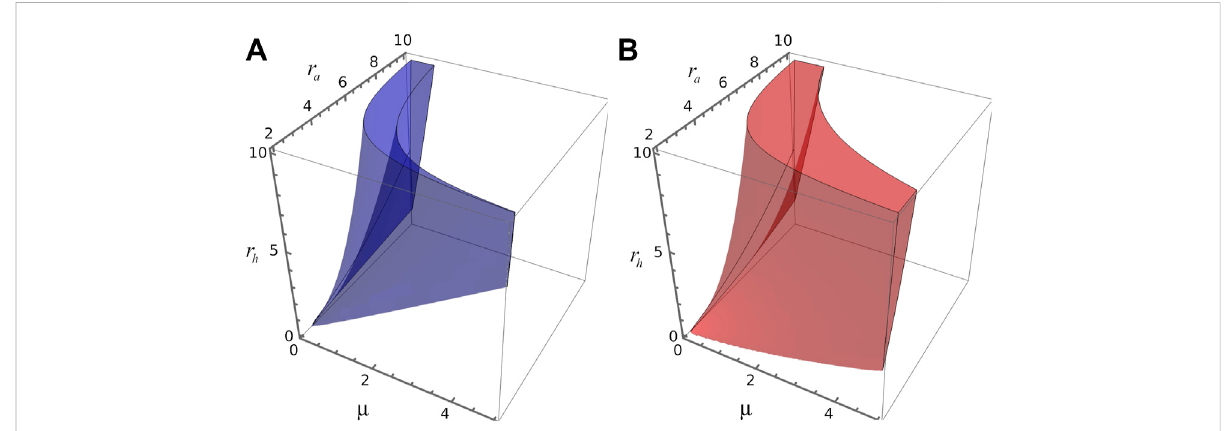
FIGURE 3 3Dparametersspace. (A) Bluevolumedelimits,inthespacespannedbyparameters( μ , r a , r h ),theregionwherethefourTuringconditionsareveri fi